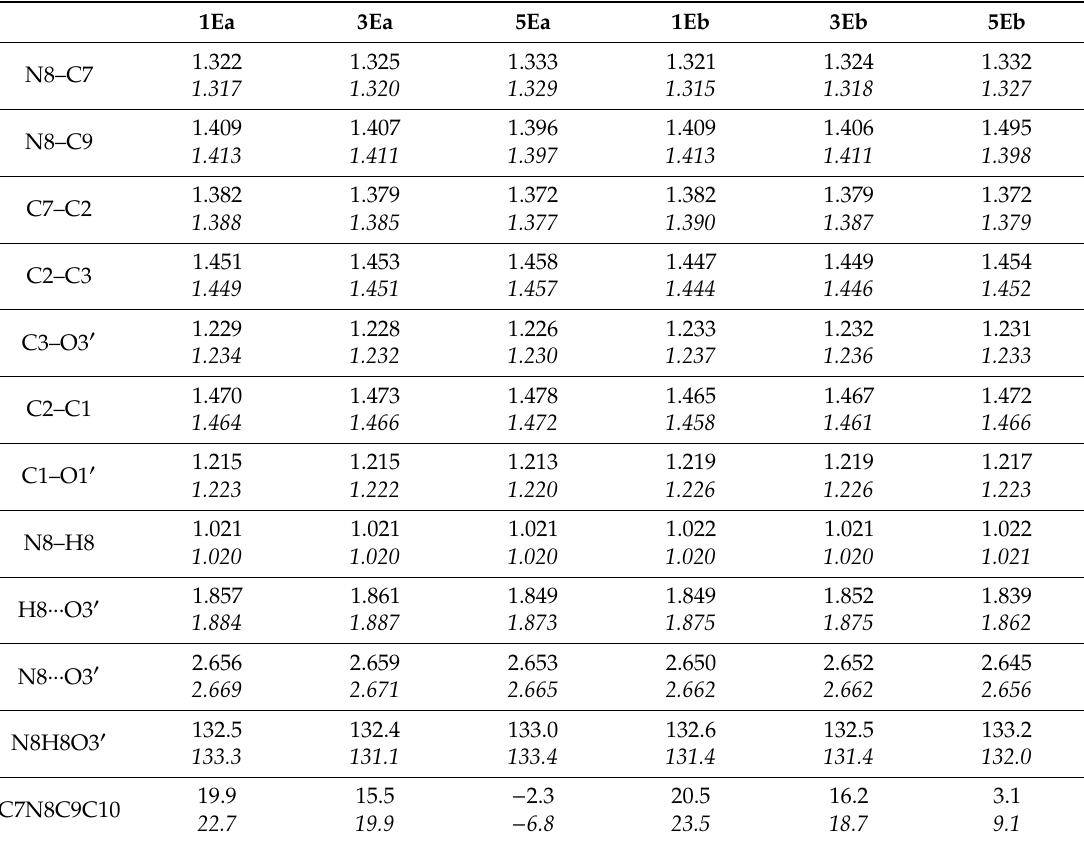
Table 3. Optimized (M06-2X / def2-TZVP) bond lengths [Å], and bond and dihedral angles [deg]